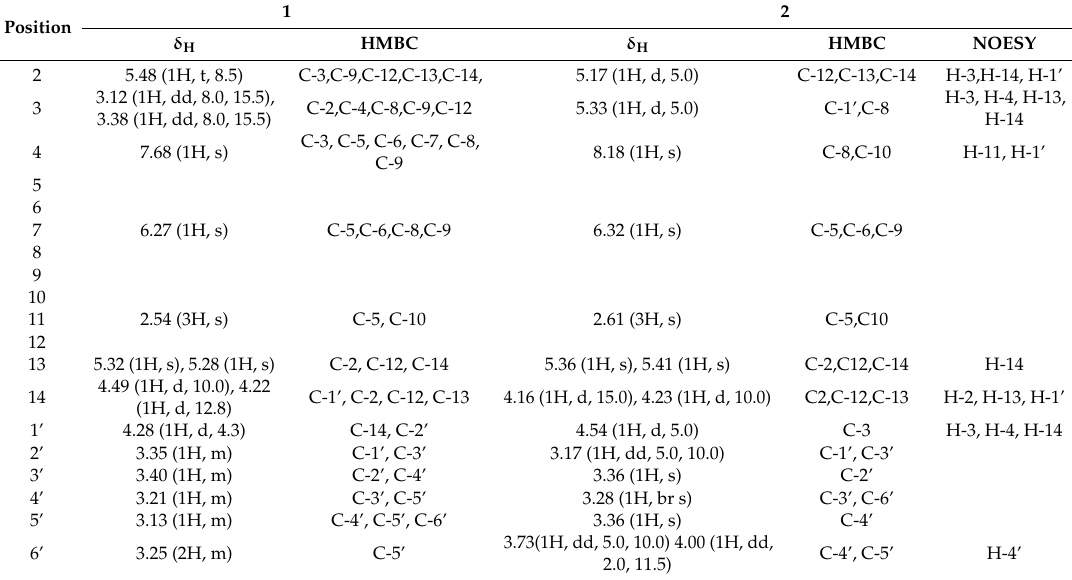
Table A1. HMBC spectroscopic data of compounds 1 and 2 (500 MHz for 1 H and 125 MHz for 13 C Data, J in Hz, recorded in